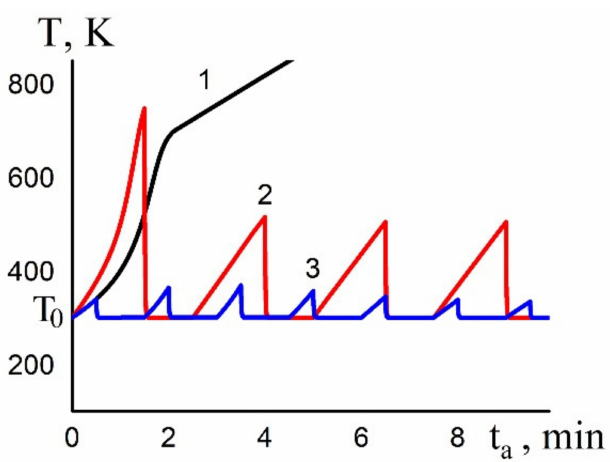
Figure 4. Theoretical dependences of temperature in the mechanically activated solid reagent– active gas system on the mechanical activation time for different activation modes and m ∑ ,0 = 0.37: 1—continuous; 2—discontinuous ( τ a / τ 0 = 1.5); 3—discontinuous ( τ a / τ 0 =